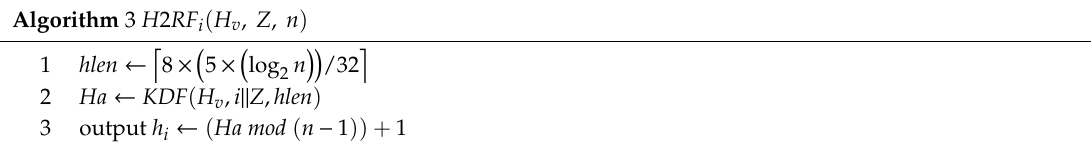
Algorithm 3 H 2 RF i ( H v , Z , n